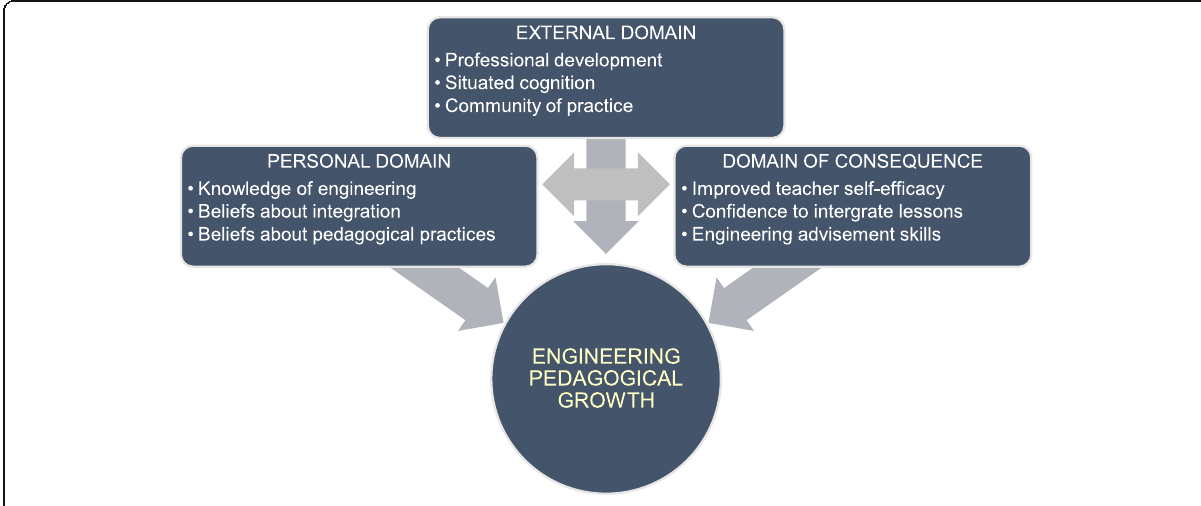
Fig. 1 Integrated model of pedagogical growth in engineering education (adapted from Clarke and Hollingsworth